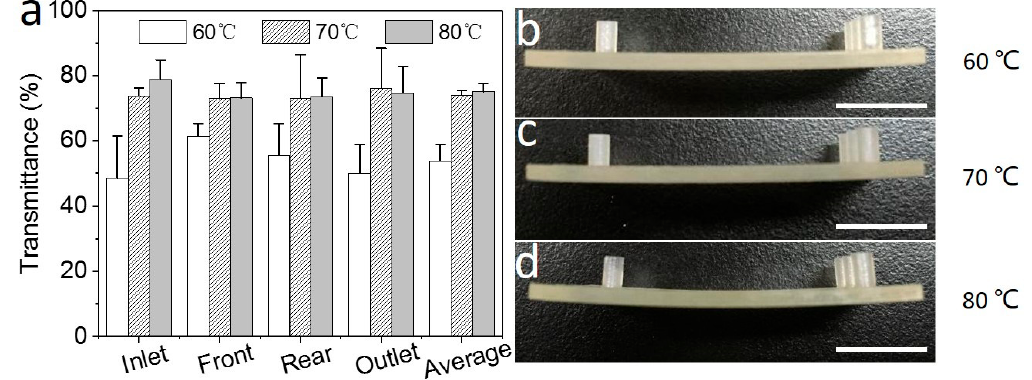
Figure 5. Removing inner sacrificial materials with different temperatures. ( a ) The microchannel transmittances of different parts in the chip and the average after processing with 60, 70, and 80 ◦ C hot vegetable oil. ( b – d ) Chip deformation after processing at ( b ) 60 ◦ C, ( c ) 70 ◦ C, and ( d ) 80 ◦ C. The scale bars are 1 cm.